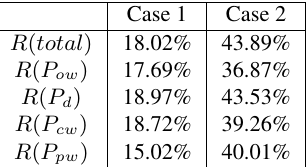
Figure 12: Tracking multiple persons with overlapping viewing ranges. Note the person in the red dress, initialized in the left image is kept tracking in the right image after partial occlusion.